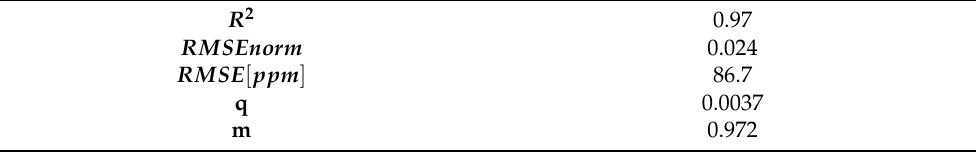
Table 6. Summary of performance prediction results for test case Bench – ECU